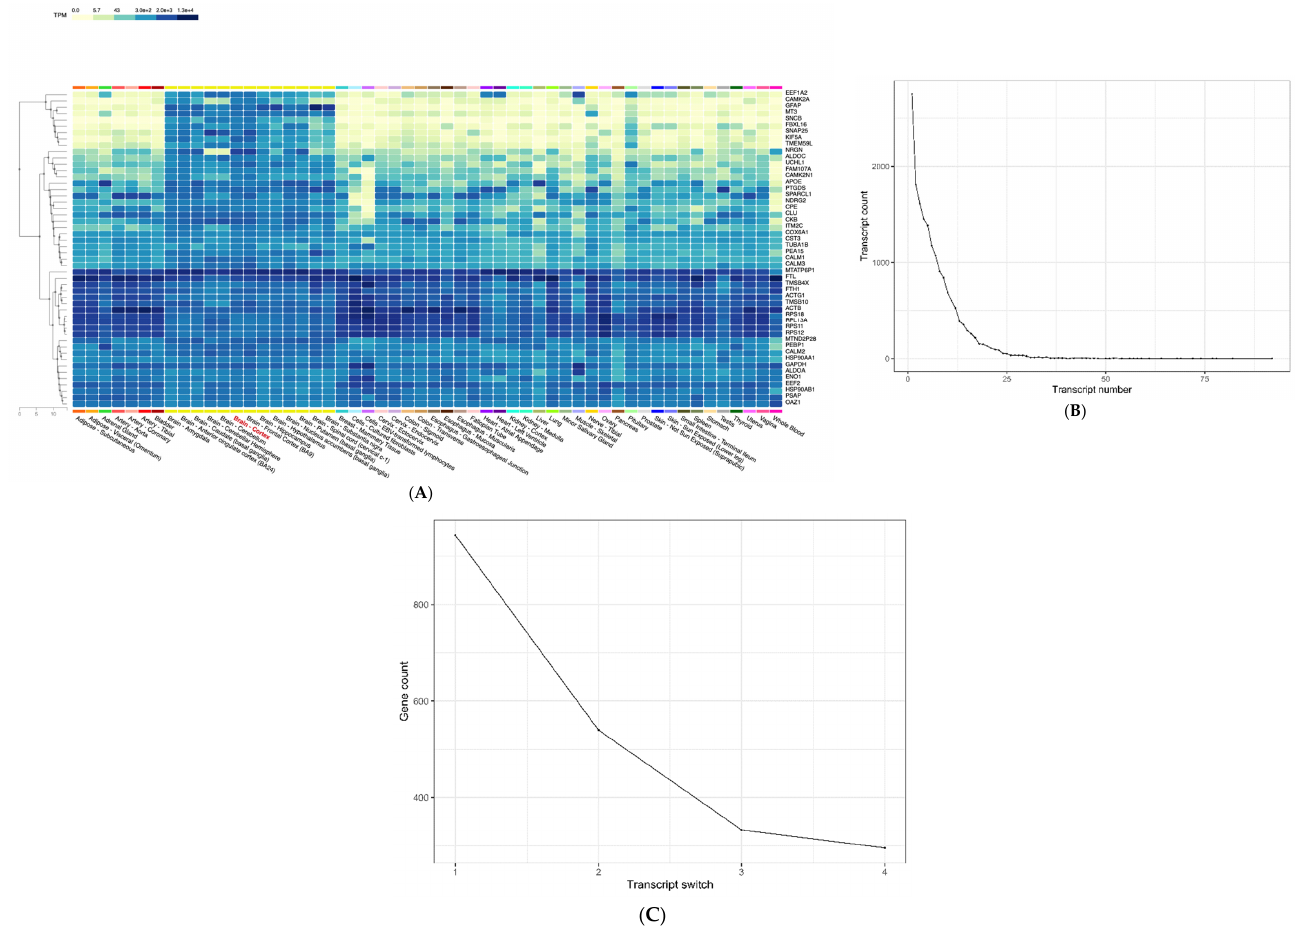
Figure 5. Transcription variability: ( A ) Tissue expression profiles of the 50 most expressed genes in the brain cortex from GTEx. ( B ) Number of protein-coding transcripts per gene using GTEx tissue data. ( C ) Rank 1 transcript switch in 1, 2, 3, or 4 out of 54 tissue datasets, using the TREGT database. Expression units are transcripts per million (TPM).